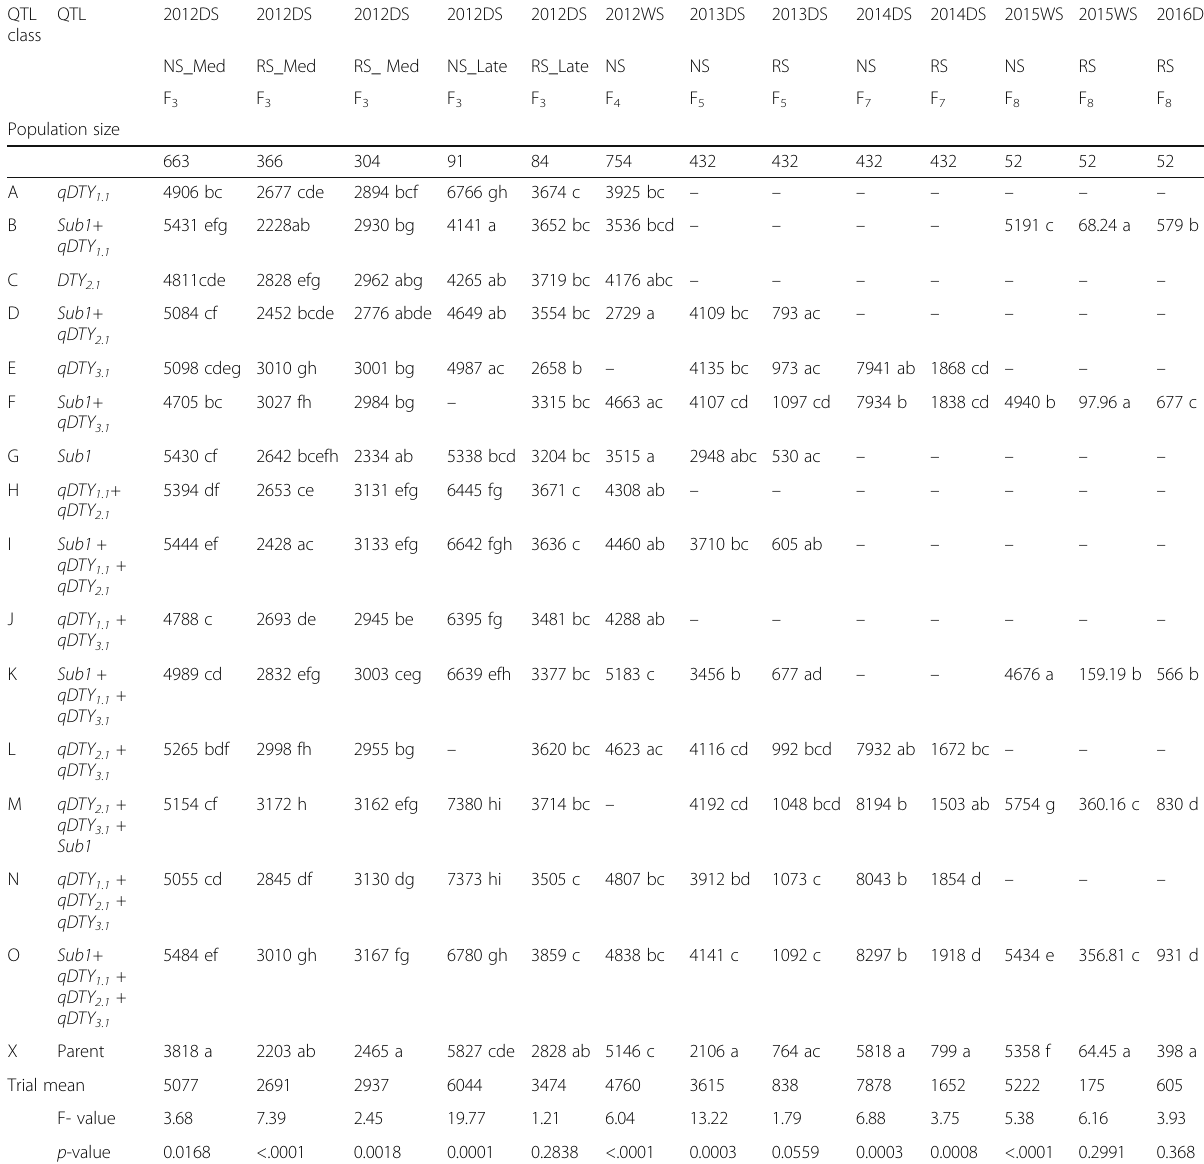
Table 1 Mean comparison of QTL classes of grain yield (kg ha − 1 ) across F 3 to F 8 generations under reproductive-stage drought stress and irrigated non-stress control conditions in Swarna-Sub1 background at IRRI,